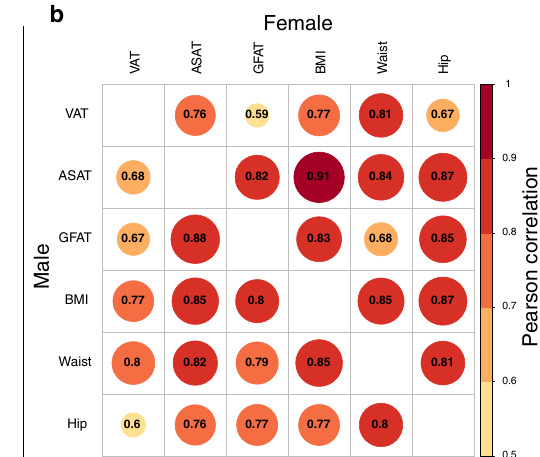
Fig. 2 | Sex-strati fi ed densityplotsand correlation plotsofvisceral, abdominal subcutaneous,andgluteofemoraladiposetissuevolumes.a Sex-andBMI-group speci fi c density plots for visceral adipose tissue (VAT), abdominal subcutaneous adipose tissue (ASAT), and gluteofemoral adipose tissue (GFAT) with dotted lines denotingmedians. b Sex-strati fi edcorrelationplotsbetweenVAT,ASAT,GFATand